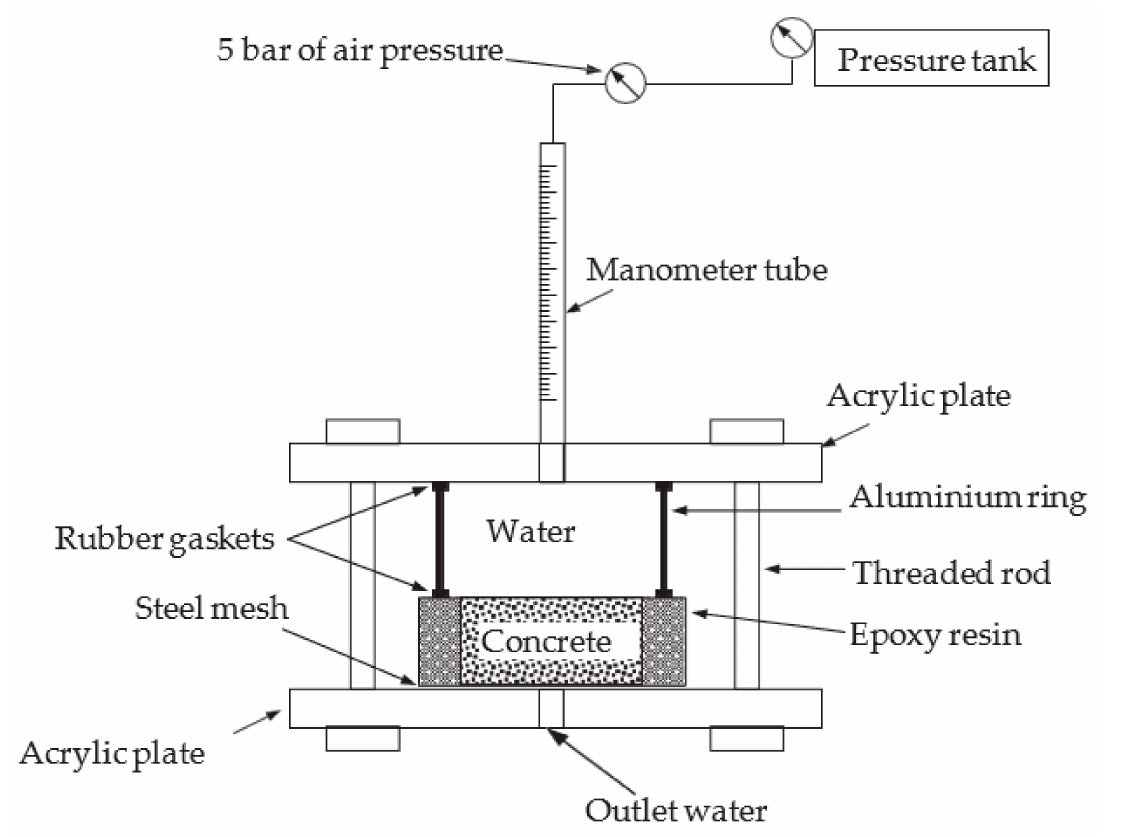
Figure 8. Water permeability test of concrete [40]. Reprinted with permission from Elsevier